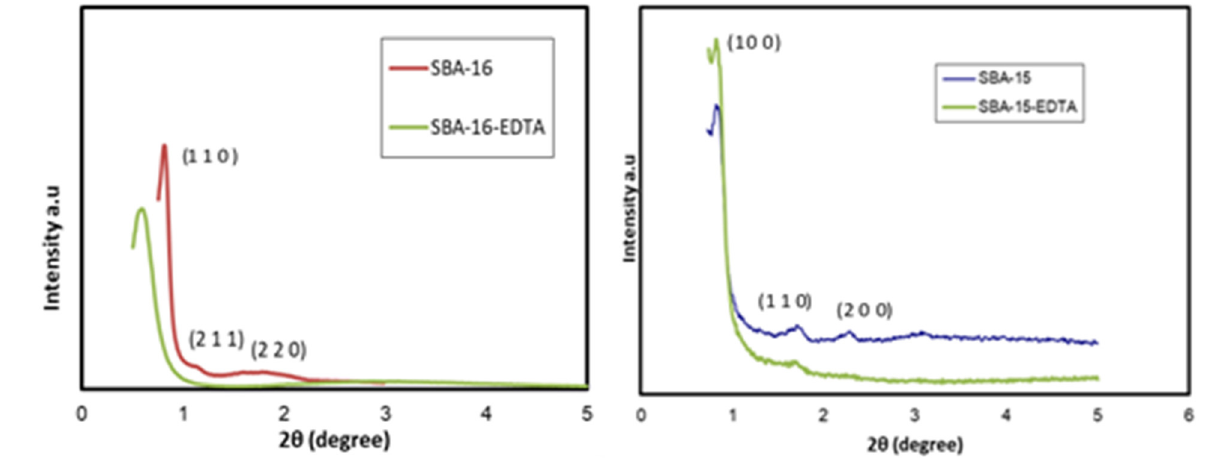
Figure 4. XRD patterns of SBA ‒ 16 and SBA ‒ 15 before and after modification.